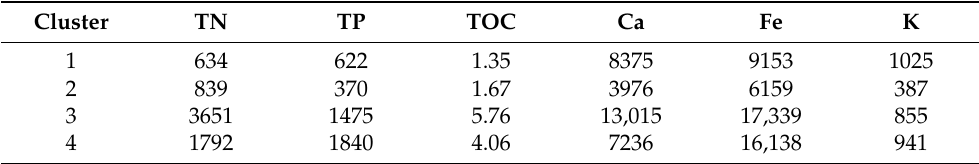
Table 10. Mean concentrations of elements (mg · kg − 1 ) and TOC (%) in sediments samples for land- use